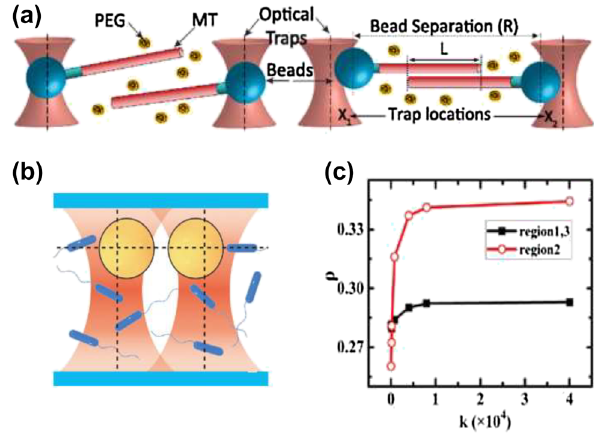
Figure 4: Depletion